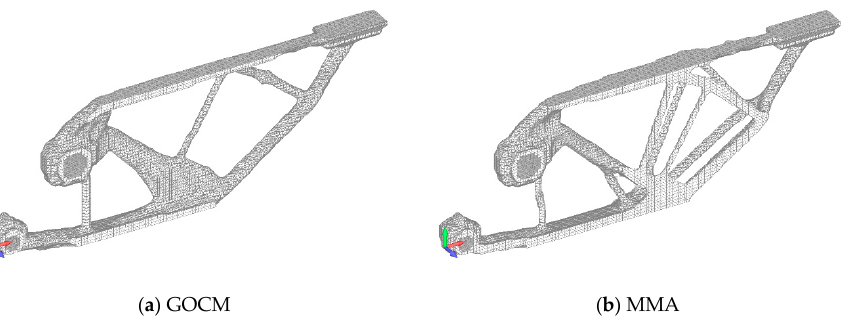
Figure 6. Optimum design of the gripper-arm model with multiple constraints. Table 4. Comparison of optimum designs with multiple constraints.